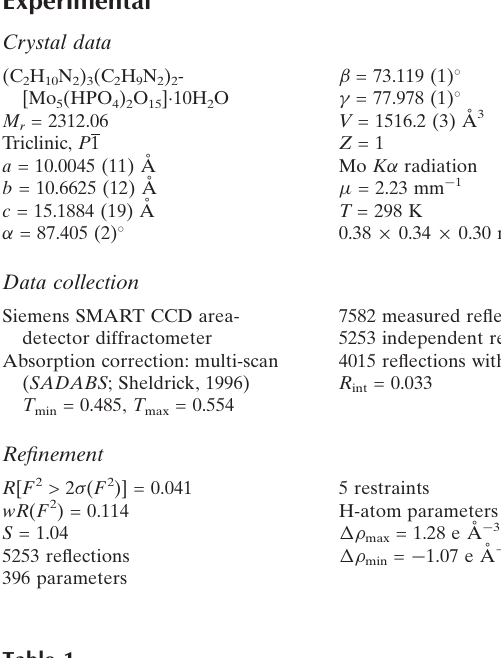
Hydrogen-bond geometry (A˚ , (cid:4) ). D —H (cid:2)(cid:2)(cid:2)